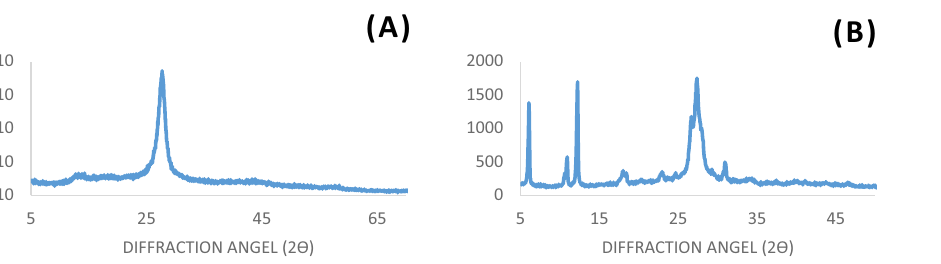
Figure 6. XRD pattern of ( a ) nanosheets g-C 3 N 4 , ( b ) g-C 3 N 4 @l-arginine.